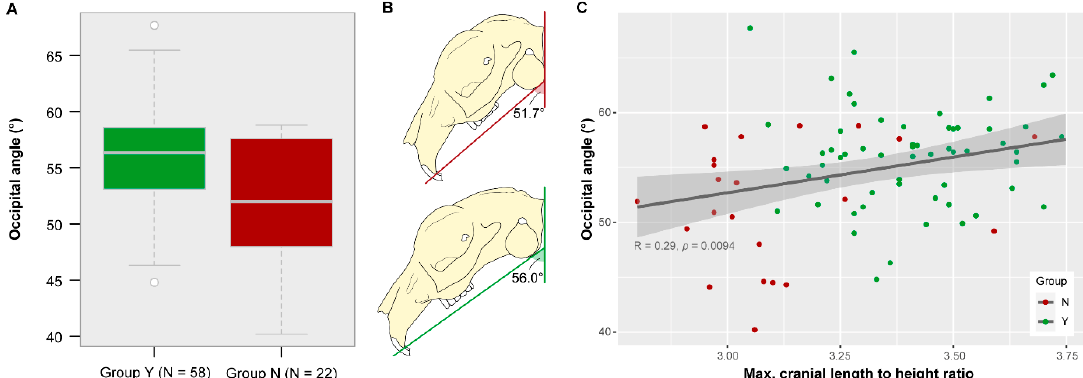
Figure 6. Variance in occipital angle. ( A ) Boxplot and ( B ) schematic visualization of the mean angle for each group. It is significantly different between group Y and group N ( p = 0.003). ( C ) Relation between occipital angle and maximal cranial length to height ratio.